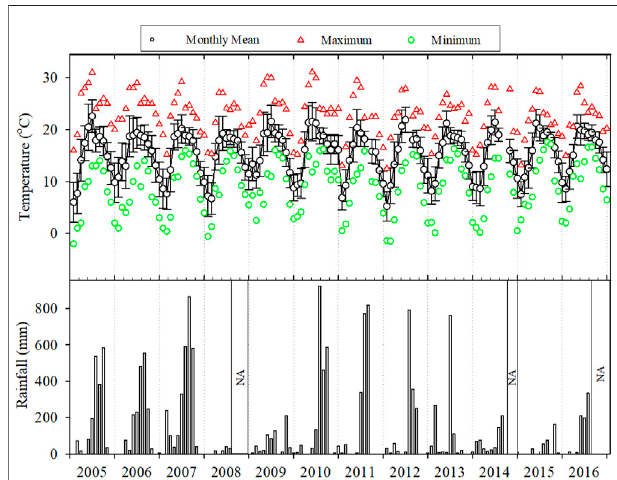
FIGURE 2| Seasonal variations in the mean temperature ( ° C), maximum temperature, minimum temperature, and total rainfall during the years 2005 – 2016 at the observational site, Nainital. Here, the hourly data are used for estimations of monthly mean temperature and total rainfall. The missing rainfall data are shown as not available